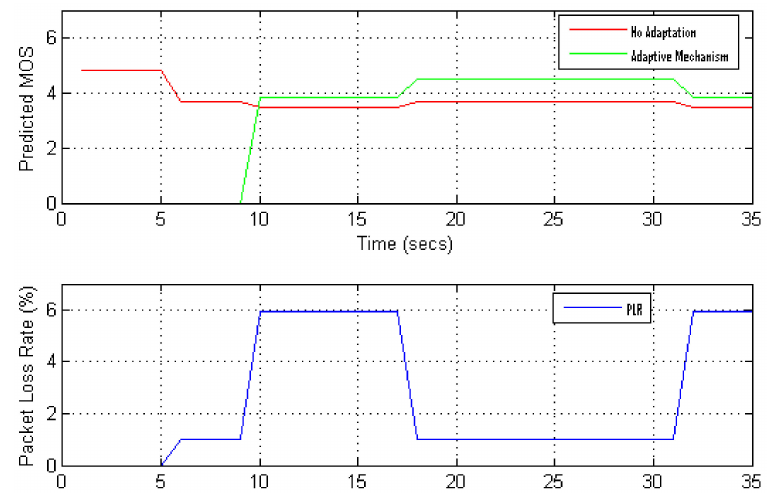
Figure 22. Device-aware adaptive